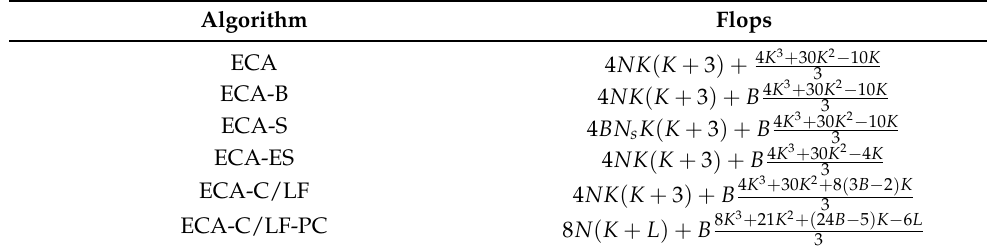
Table 1. Flops of different ECA verisons within the evaluation